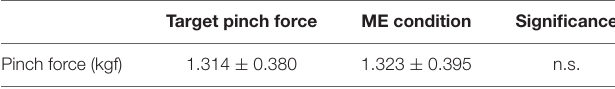
TABLE 1 | The comparison for pinch force between the motor execution (ME) condition and the target pinch